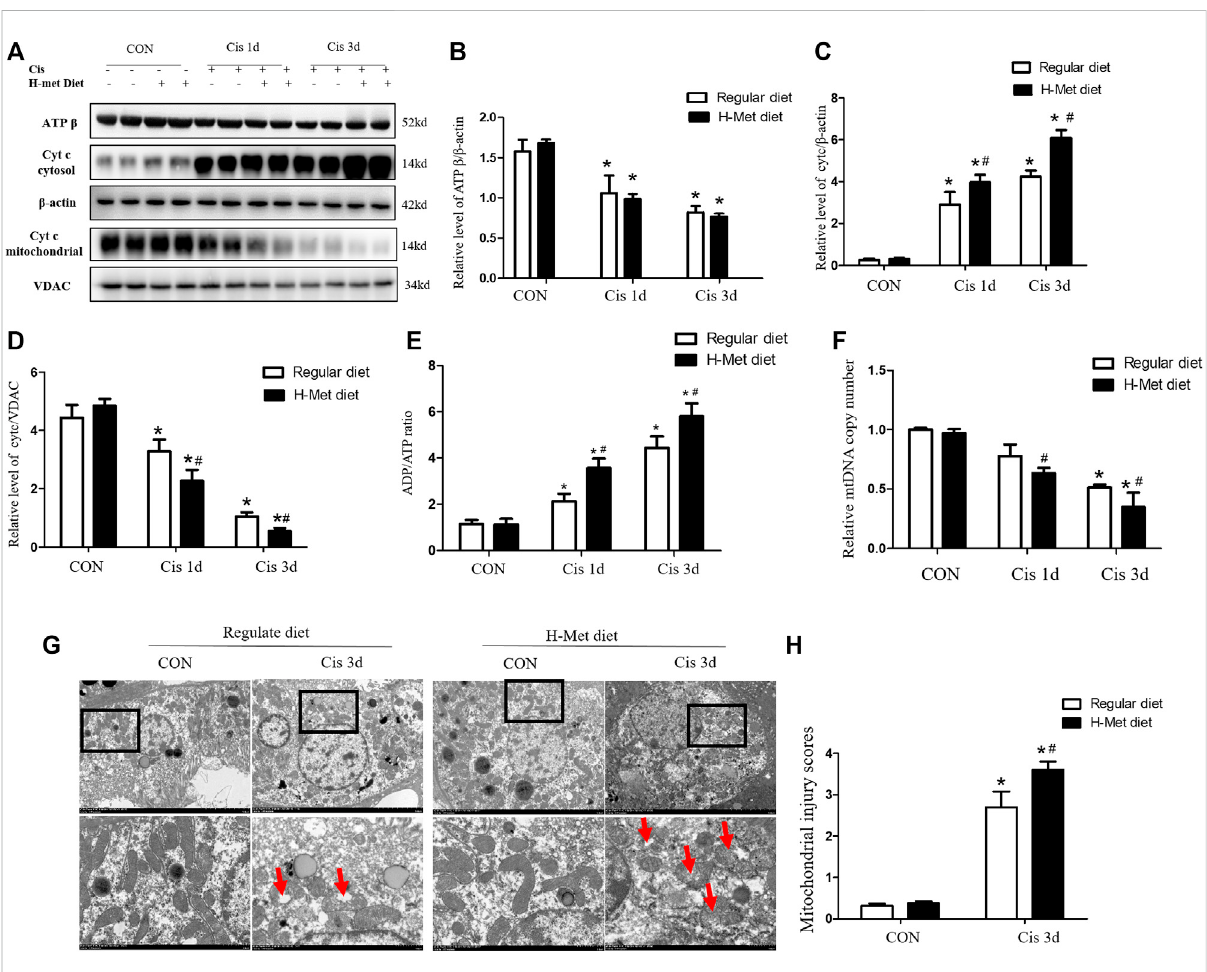
FIGURE 2 Hyperhomocysteinemia promotes cisplatin-induced mitochondrial damage of kidney in mice. (A – D) Western blot analysis of ATP β and Cyt C (incytoplasmormitochondria)inkidneyaftercisplatininjection. (E) LeveloftheATP/ADPratioinmice. (F) Quanti fi cationofmtDNAcopynumber. (G) Electron micrographs reveal obvious morphological changes of mitochondria in renal tissue of HHcy mice at day 3 after cisplatin injection. Upper panel: scale bar, 5 μ m; magni fi cation 3000×. Lower panel: scale bar, 1 μ m; magni fi cation 8000×. The red arrows ( )suggest changes in mitochondrial structure in the proximal renal tubular cells, including mitochondrial shortening and roundness, mitochondrial fragmentation, mitochondrial swelling and vacuoles, crest loss. (H) Statistical quanti fi cation analysis showing injury score of mitochondrial. Data expressed as mean ± SD; n = 5 – 7 per group. * p < 0.05 versus control; # p < 0.05 versus mice fed with regular